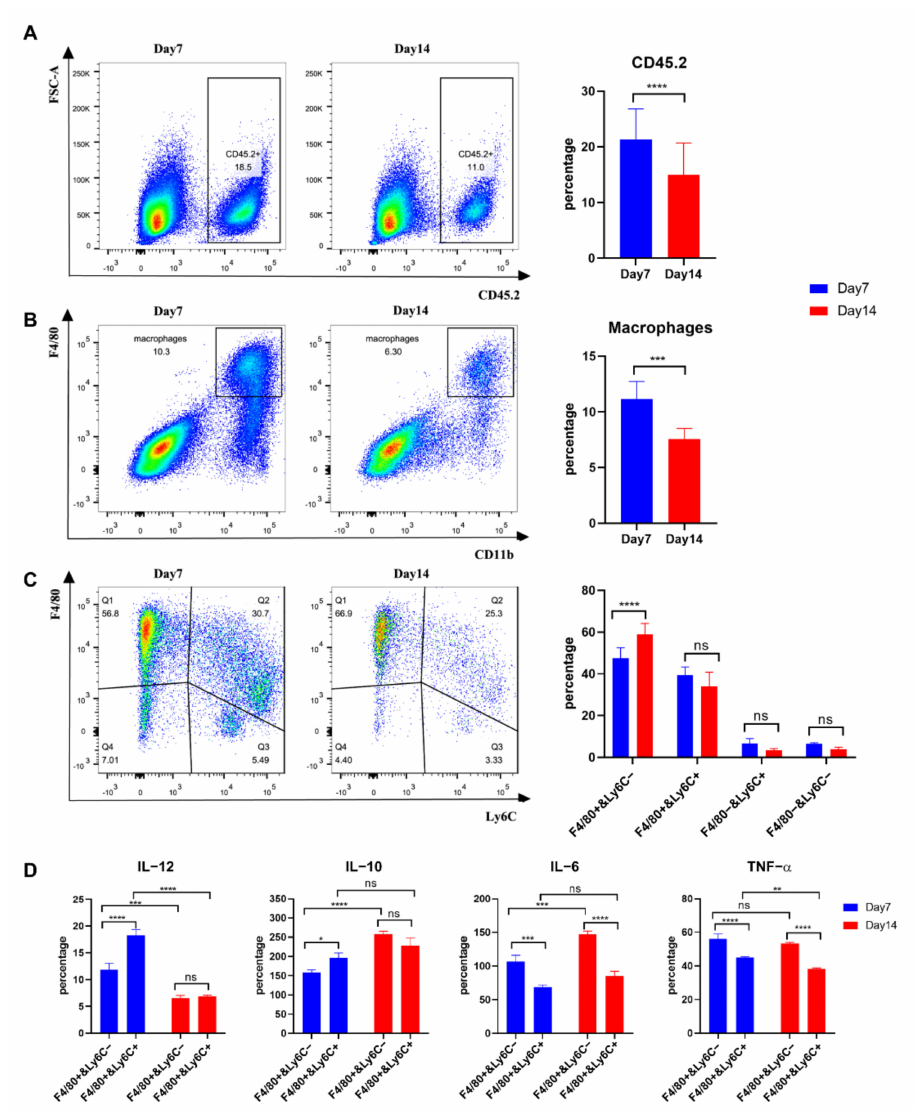
Figure 5. Comparison of the macrophage phenotypes in 7- and 14-day TC-1 tumours. ( A ) Comparison of CD45+ cell populations; ( B ) Comparison of overall macrophage populations; ( C ) comparison of four subpopulations of macrophages, including F4/80+Ly6C − , F4/80+Ly6C+, F4/80-Ly6C − , and F4/80-Ly6C+; ( D ) secretion of IL-12, IL-10, IL-6 and TNF- α by different M Φ subpopulations at early- or late-stage. Student’s t -test was used to evaluate the significance (ns: non-significant, *: p < 0.05, **: p < 0.01, ***: p < 0.001 and ****: p < 0.0001). 3.6. IFN- α Response Signalling Pathway Activated Macrophages Are Increased in Early-Stage Cervical